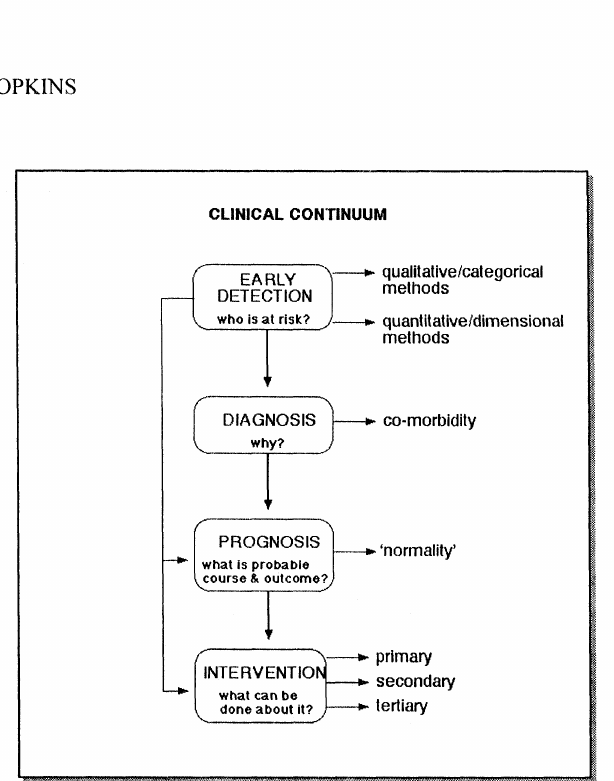
Fig. 1" The clinical continuum that contains a sequence of interrelated aspects, but with each one addressing a particular question. Topics relevant to each aspect that are discussed in the text are referred to on the right hand side of the figure. The continuum represents an ideal sequence of clinical activities starting with early detection and proceeding through diagnosis and prognosis to therapeutic intervention. Sometimes both prognosis and inter- vention may follow on from early detection (without diagnosis) as indicated by the thin arrow- headed lines. In these instances, primary inter- vention is the goal in an attempt to prevent the probable occurrence of some later emerging general disorder (for example, cerebral palsy or cognitive deficits in preterm